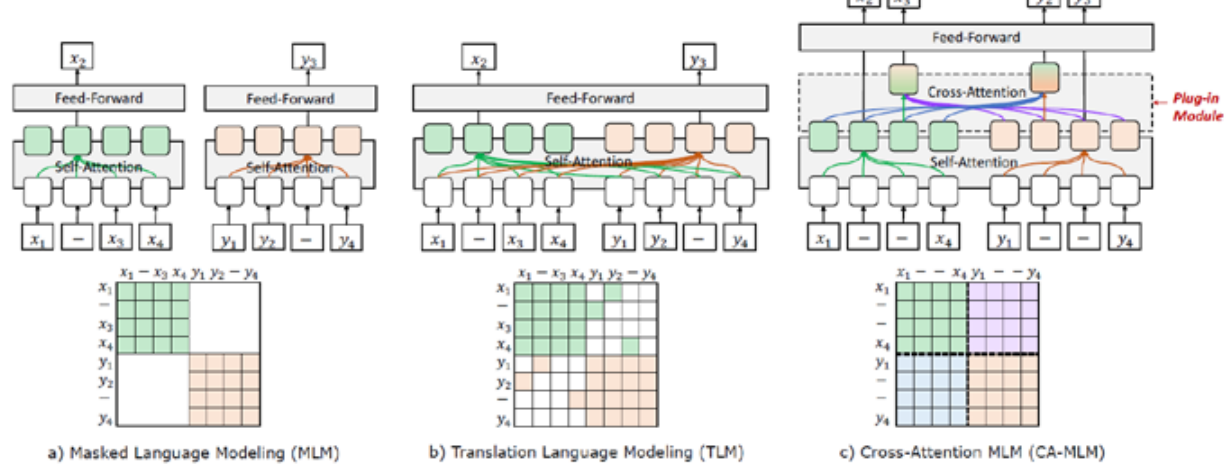
Figure 9 Cross-language pre-training task and its attention matrix [29].